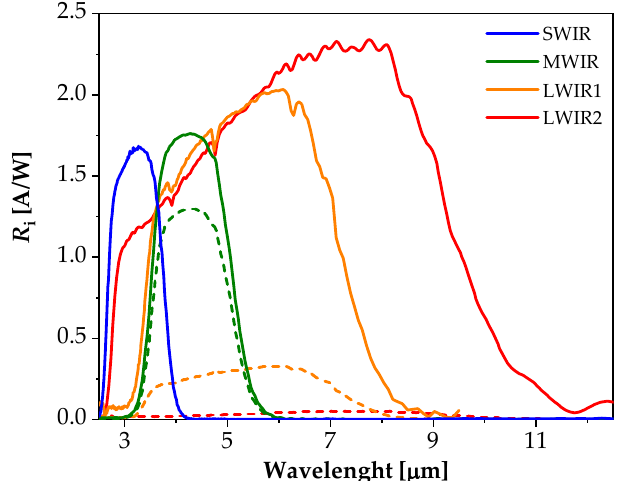
Figure 3. Spectral characteristics of SWIR, MWIR, and LWIR diodes without (dashed line) and with (solid line) reverse bias voltage measured at a temperature of 300 K.